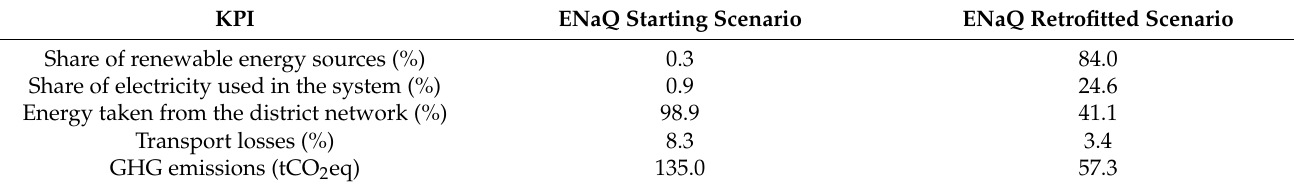
Table 4. KPI comparison between ENaQ starting and retrofitted